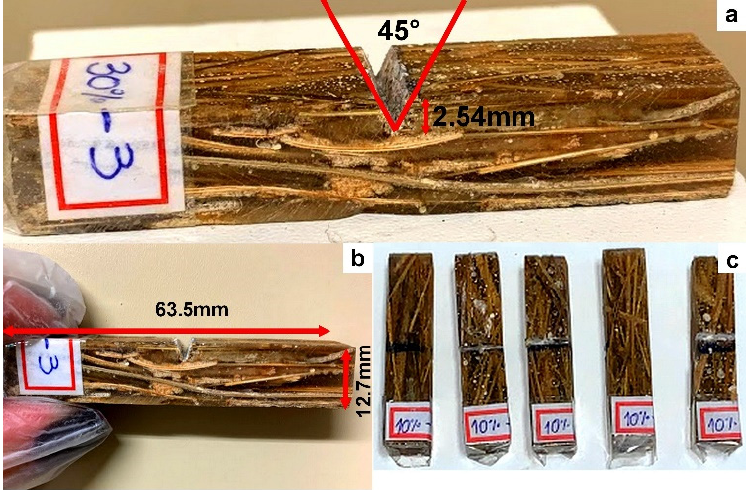
Figure 2. Izod impact test specimens. ( a ) measure of the notch ( b ) measure of length and thickness ( c ) some samples of 10% vol.